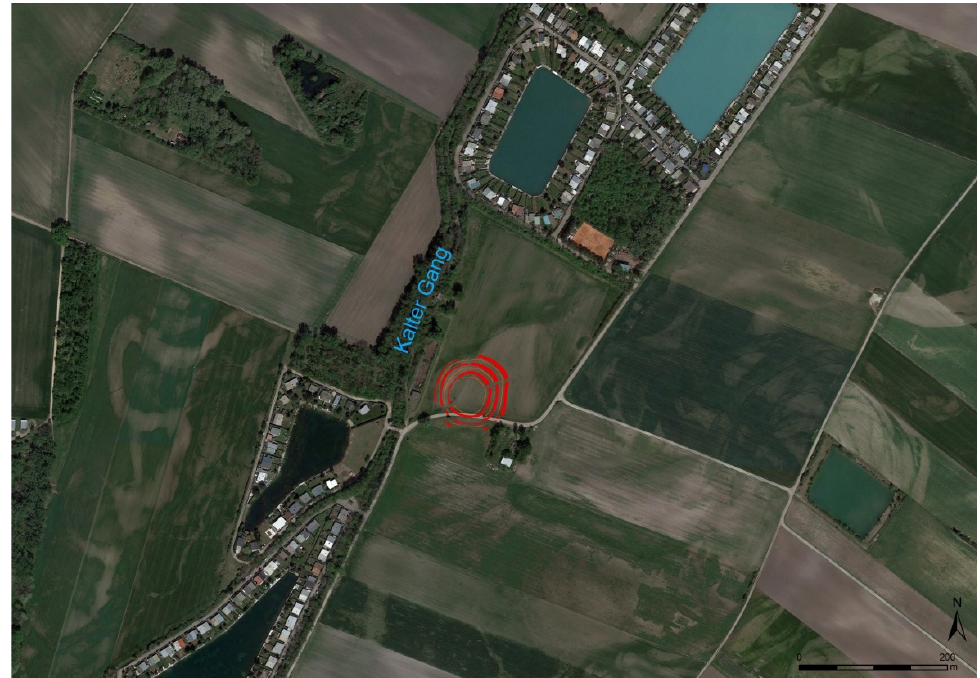
Figure 4. A photomontage of two aerial photographs from GoogleEarth (04/2018 and 04/2019, http://www.earth.google.com, accessed on 23 April 2022 ) showing the Middle Neolithic KGA Velm (highlighted in red) surrounded by paleomeanders. Nowadays, the regulated course of the nearby river Kalten Ganges flows in a lowland, only a few meters to the west.